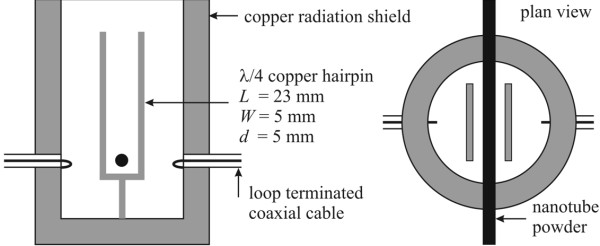
Schematic diagram of the copper hairpin resonator. Samples are placed at the magnetic field antinode shown with H parallel to the axis of the quartz tube holding the powder sample. L, length; W, width; d, diameter.